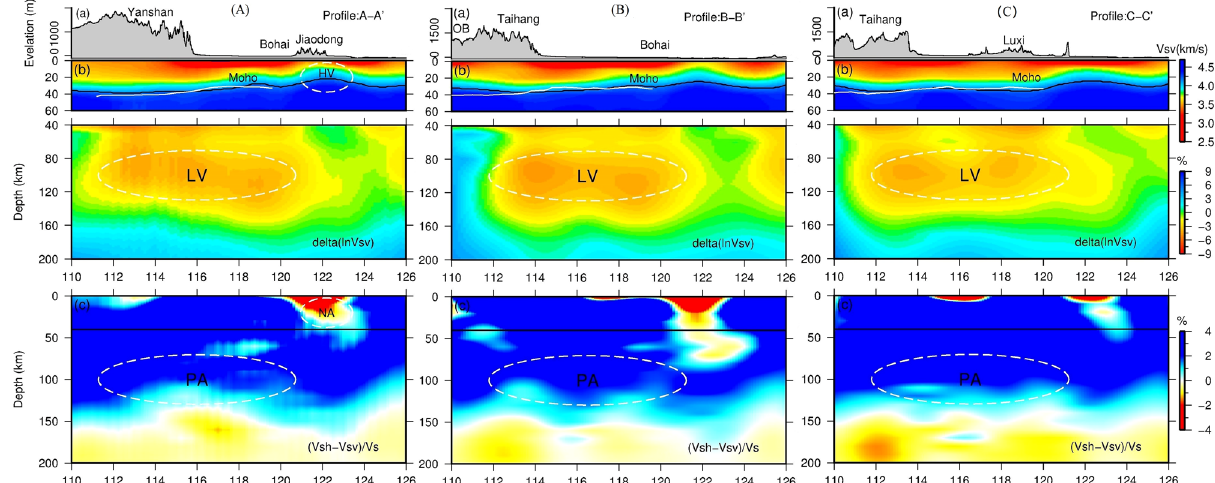
Figure 3. Three vertical cross sections with surface elevation, velocity anomaly and radial anisotropy along profile A–A ′ ( A ), B-B ′ ( B ) and C–C ′ ( C ). Surface altitude (top, a), Sv-wave velocity anomalies (middle, b), and radial anisotropy (V SH -V SV )/V S (bottom, c). For sub-graph b, absolute velocity is adopted for the crust (top 60 km), and velocity perturbation is adopted in upper mantle (40–200 km) with reference model: PREM (Dziewonski and Anderson 1981). White solid line denotes the depth of Moho obtained from receiver function (Chen 2009; Zheng et al. 2014); black solid line denotes the depth of Moho derived from reference shear wave velocity of 4.2 km/s. LV: low velocity; HV: high velocity; NA: negative anisotropy; PA: positive anisotropy. The map in the figure was generated by the Generic Mapping Tools package 115 (GMT-4.5.9, https:// www. gener ic- mappi ng- tools. org/).